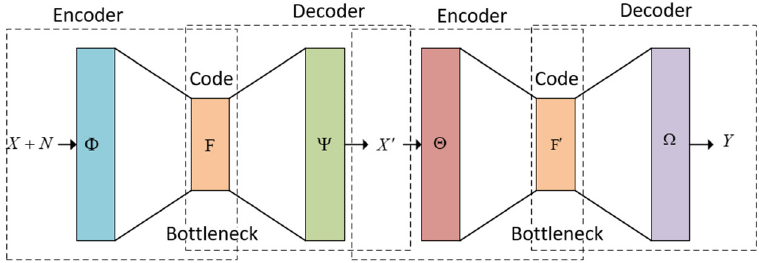
Figure 2. The dual autoencoder structure.